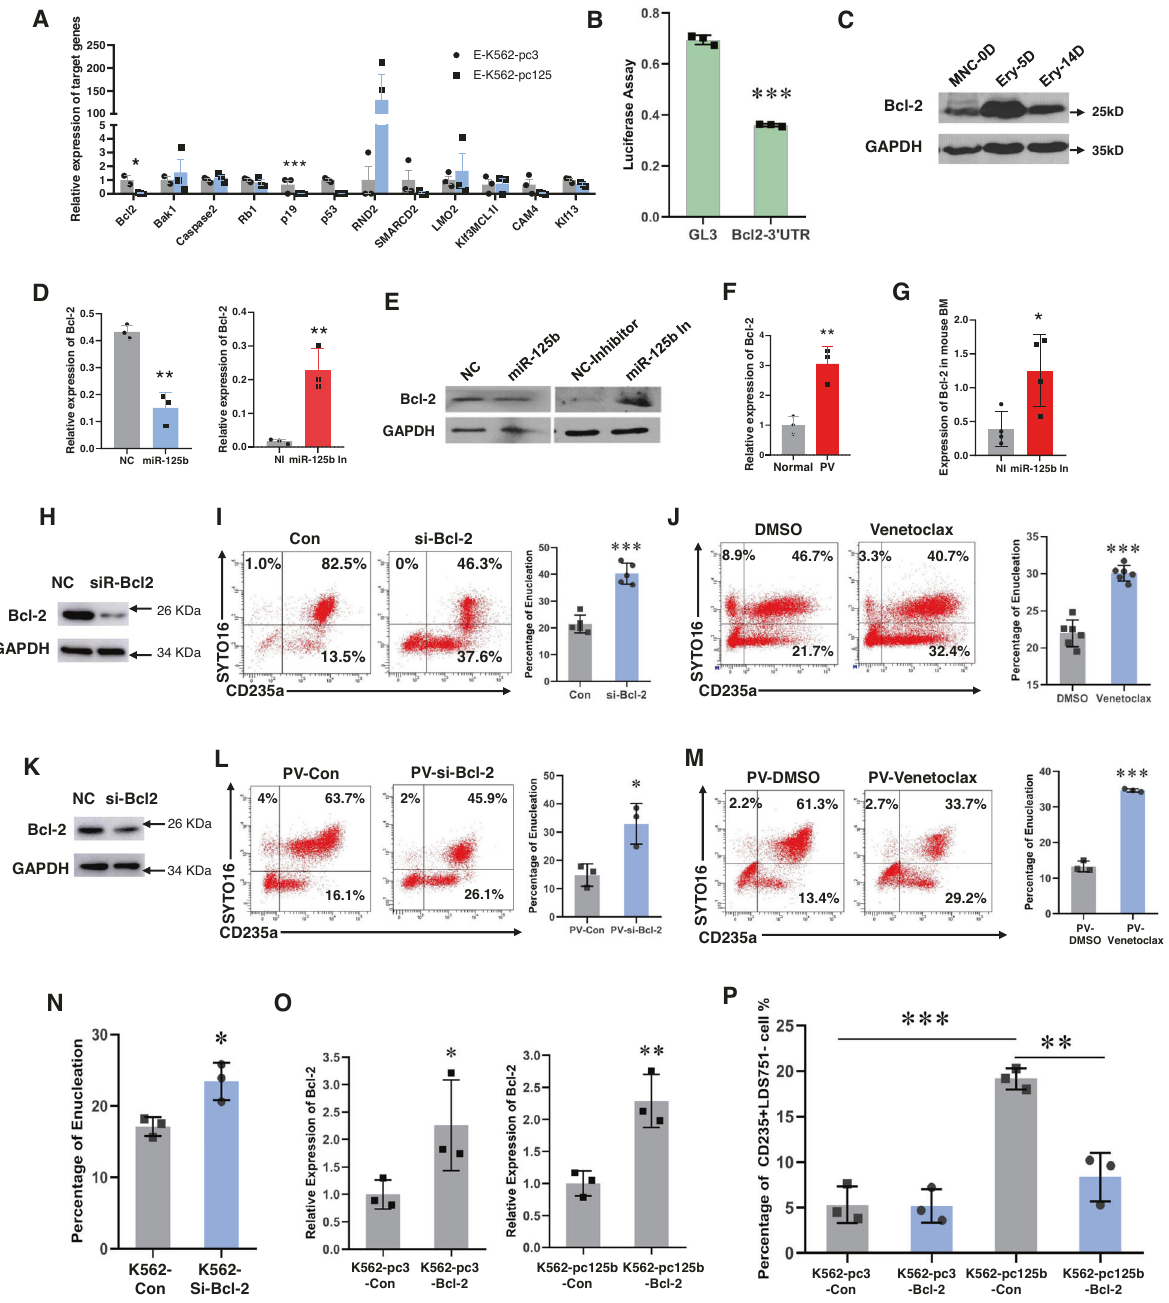
Mouse fetal liver (mFL)-derived erythroblasts . Erythroblasts were puri fi ed from E13.5 mFL cells and cultured and differentiated as previously described